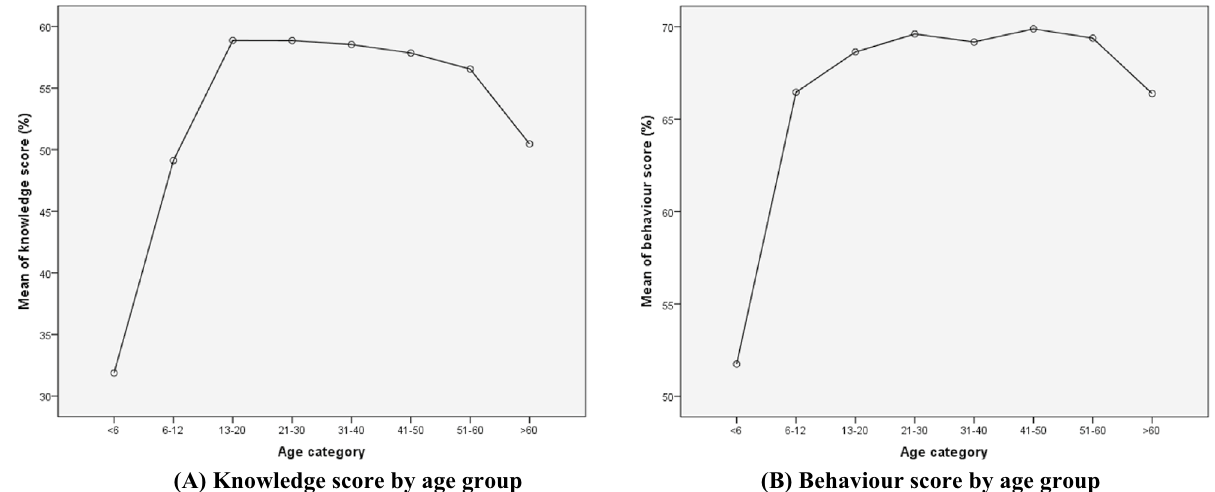
Figure 1. Mean scores of observed knowledge and behavior scores (%) by age group.